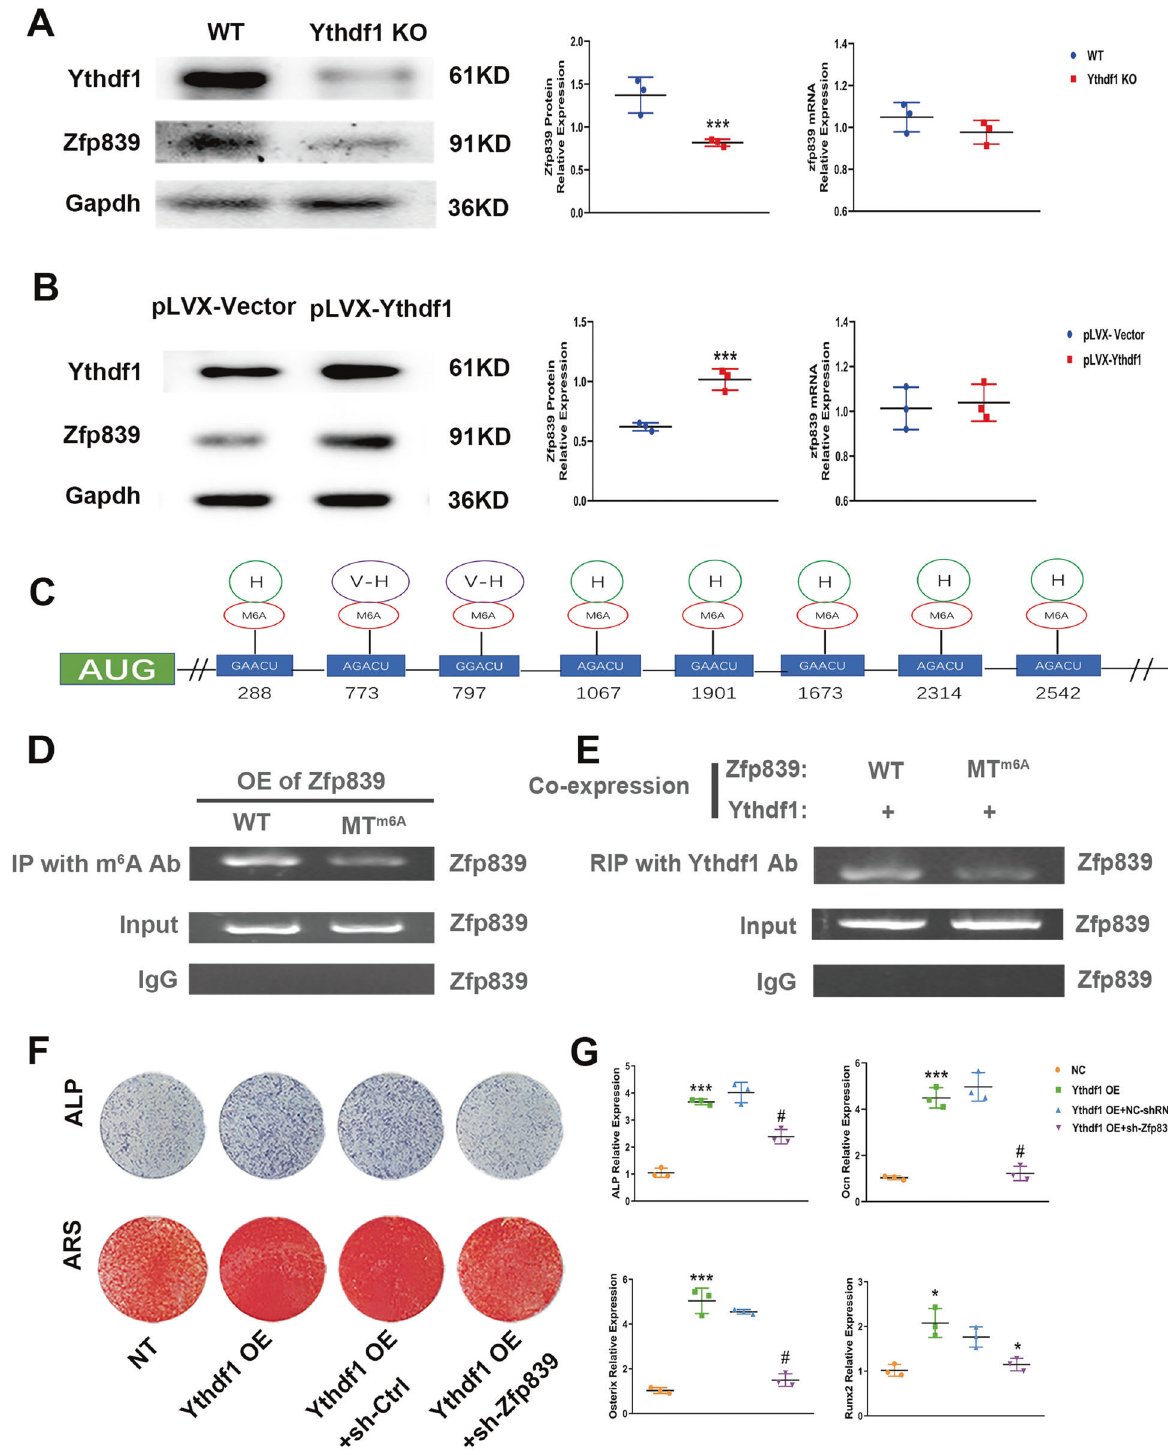
Fig. 4 Zfp839 mRNA is modi fi ed by m 6 A and binds to the m 6 A reader Ythdf1. A , B Western blot analysis and RT-PCR analysis showing Zfp839 protein and mRNA levels by Ythdf1 KO or overexpression. ***P < 0.01 versus WT or pLVX-Ythdf1 samples. C SRAMP program predicted m 6 A sites in Zfp839 mRNA. H: highly putative predicted m 6 A sites; V-H: very highly putative predicted m 6 A sites. D Veri fi cation of the m 6 A modi fi cation in Zfp839 mRNA. Anti-m 6 A IP failed to pull down Zfp839 mRNA from C3H10T1/2 cells expressing Zfp839 with mutated m 6 A sites (Zfp839-MTm 6 A) compared with Zfp839-WT. E Binding of Ythdf1 to Zfp839 mRNA is m 6 A-dependent. RIP using the Ythdf1 Ab failed to pull down Zfp839 mRNA from C3H10T1/2 cells co-expressing Ythdf1 and Zfp839 with mutated m 6 A sites (MTm 6 A) compared with WT Zfp839. F ALP and Alizarin Red staining were performed to detect osteogenesis of BMSCs after Ythdf1 overexpression or Ythdf1 overexpression combined with Zfp839 knockdown. G mRNA levels of Alp, Ocn, Osterix, and Runx2 were detected after Ythdf1 overexpression or Ythdf1 overexpression combined with Zfp839 knockdown. *P < 0.05, ***P < 0.01 versus NC samples; and *P < 0.05, # P < 0.01 versus Ythdf1 overexpression samples. Abbreviations: IP, immunoprecipitation; RIP, RNA immunoprecipitation. Cell Death and Disease (2021)